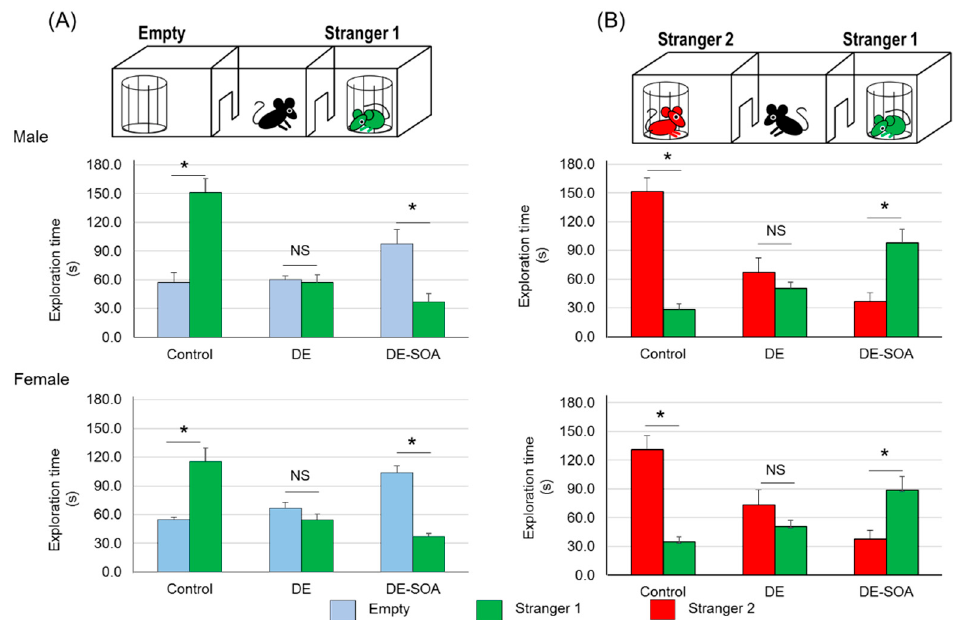
Table 1. Body weight and brain weight of male and female offspring rats.